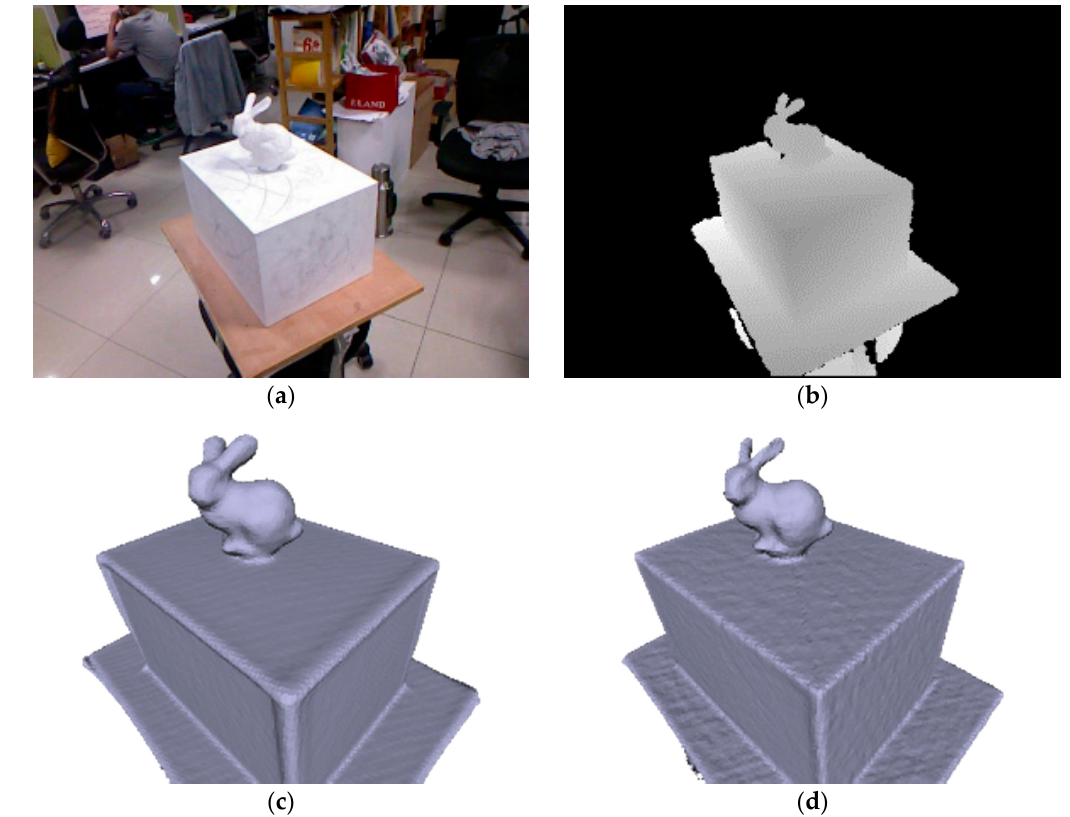
Figure 1. ( a ) Color (not used) and ( b ) depth image from our input sequence “lambunny”; ( c ) KinectFusion: mild accumulated camera drift and simple moving average truncated signed distance function (TSDF) fusion result in reconstruction inflation; ( d ) Our approach, CuFusion, keeps drift free camera tracking with additional constraints of a cuboid reference object and preserves the fidelity of the reconstructed objectives using our prediction-corrected TSDF fusion strategy. Note the sharpness of the cuboid edges and the thinness of the character’s ears of our reconstruction.